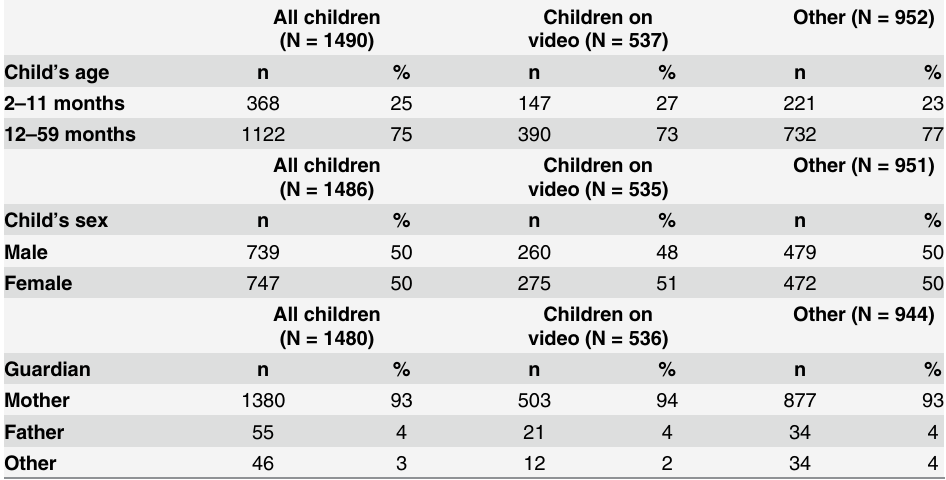
Table 1. Characteristics of children observed.